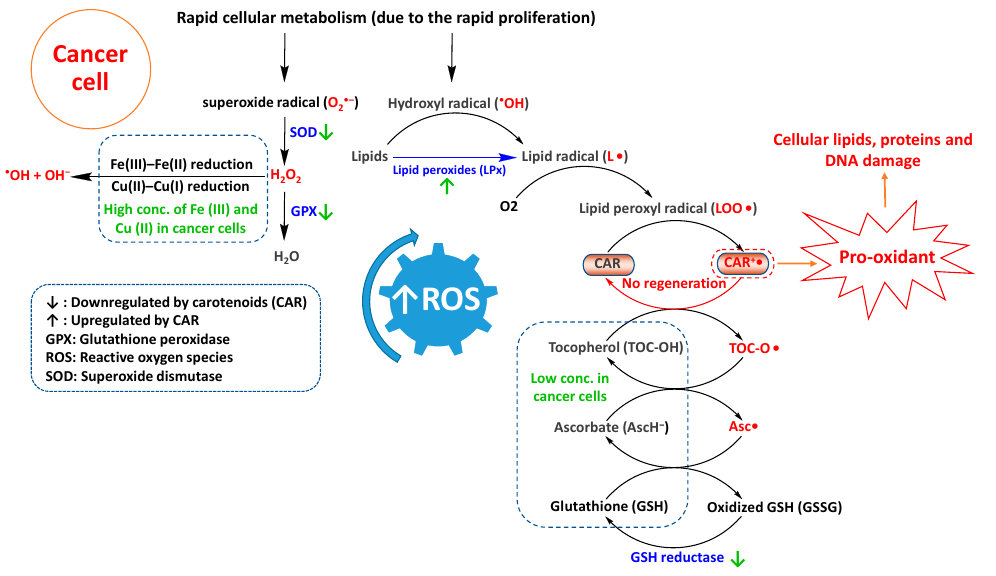
Figure 2. Possible routes of carotenoids-triggered reactive oxygen species (ROS) production in cancer cells.